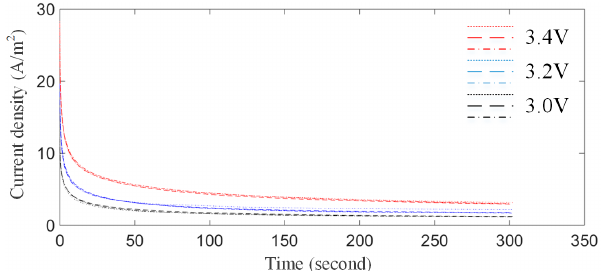
Figure 7. Electrodeposition current for different potential. For each of the three potentials, currents were measured three times. The three measured currents match each other well, which means that the repeatability of proposed 3D hydrogel patterning system is high. The used electrode is 5 mm × 5 mm in size.